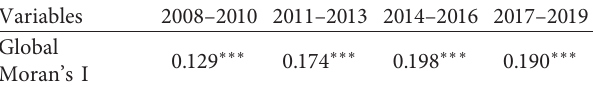
Table 3: Global Moran’s I of high-tech enterprises identified in